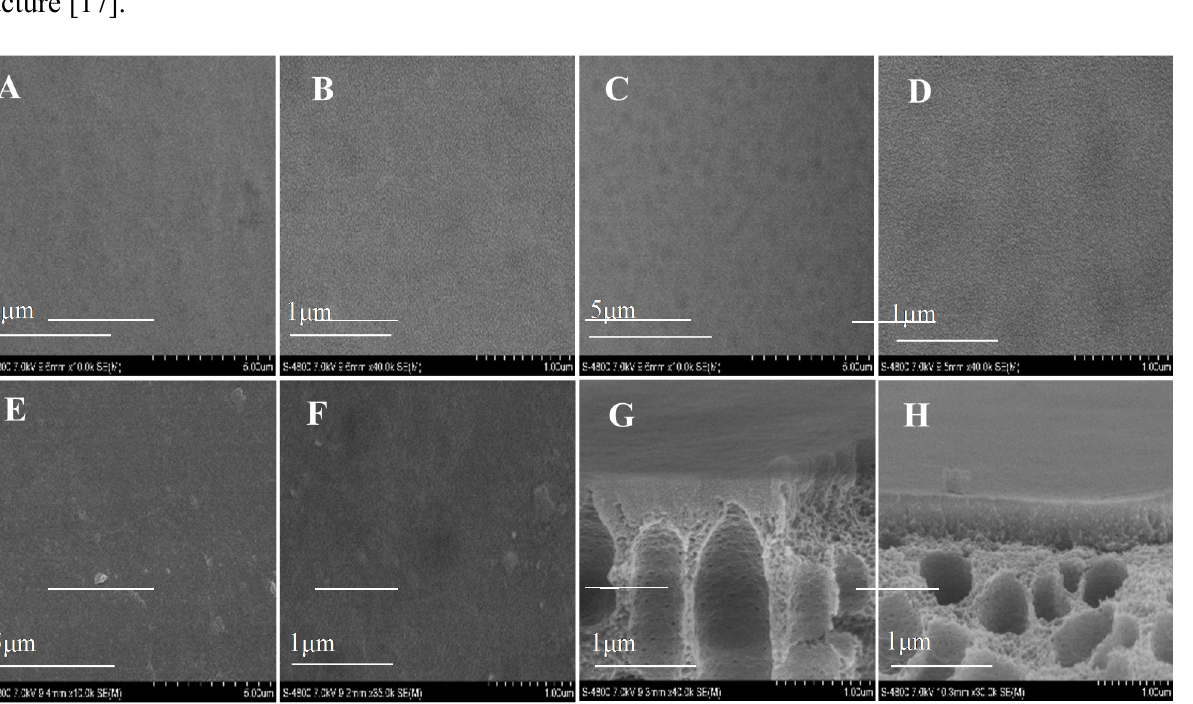
Figure 4. SEM images of various membranes. ( A , B ) top surface of T-PSS membrane; ( C , D ) bottom surface of T-PSS membrane; ( E , F ) top surface of T-AqpZ membrane; ( G ) cross-section of top surface of T-PSS membrane; ( H ) cross-section of bottom surface of T-PSS